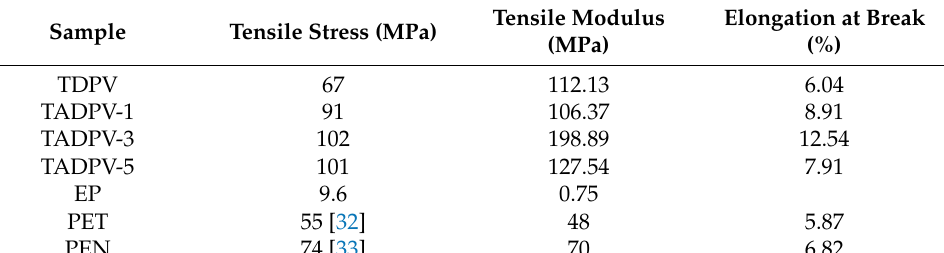
Table 1. Comparison of the mechanical properties of all of the specimens and other plastic substrates.